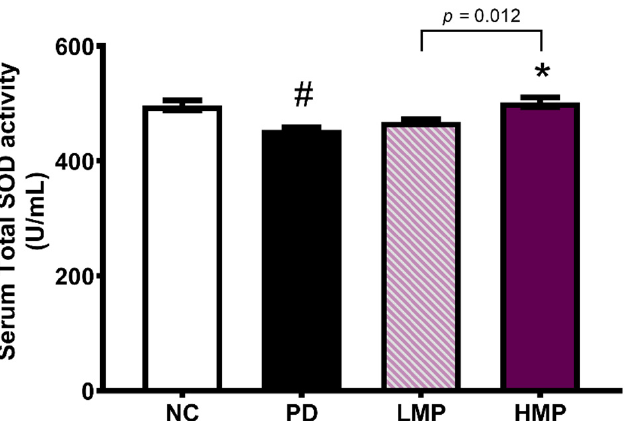
Figure 4. Serum levels of total superoxide dismutase (SOD) after 8 weeks of supplementation in the rat model of PD. All data are average ± SEM for n = 5 rats/group and were analyzed using one-way ANOVA with Tukey’s post hoc test. # p < 0.05 for the Parkinson’s disease (PD) group vs. normal control (NC) group; * p < 0.05 for low-dose mangosteen pericarp (LMP) and high-dose mangosteen pericarp (HMP) groups vs. the PD group.